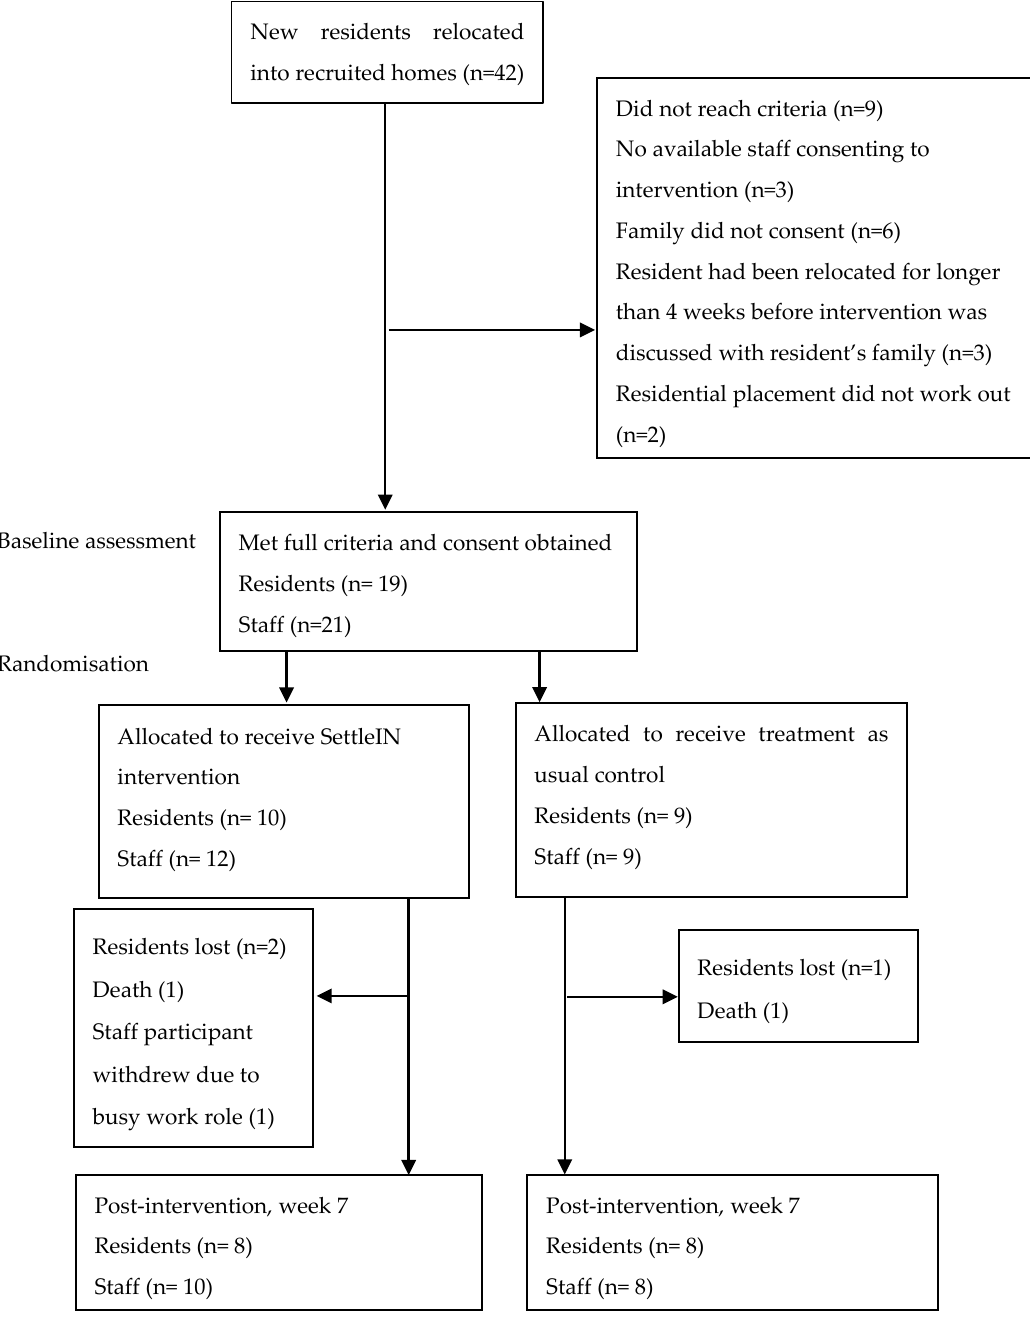
Figure 1. Resident participant flow chart.